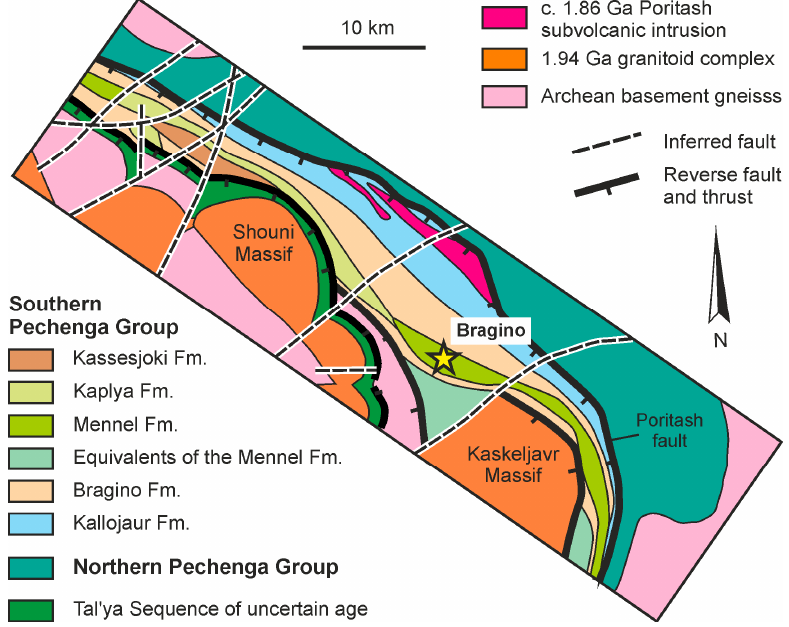
Figure 3. Geological map of the South Pechenga structural zone composed of the Southern Pechenga Group (modified from [23]).